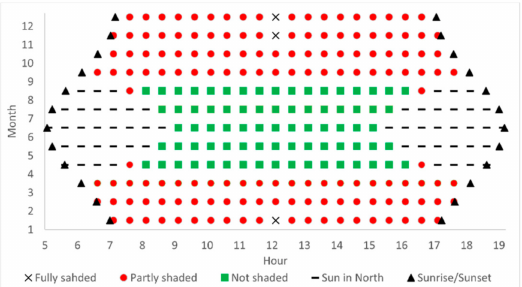
Figure 6. State of shading: north-facing surface, latitude 32 ◦ N, D = 20 m, H = 20 m, L = 40 m.